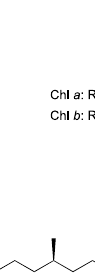
Figure 1. Chemical structure of chlorophyll a and b.